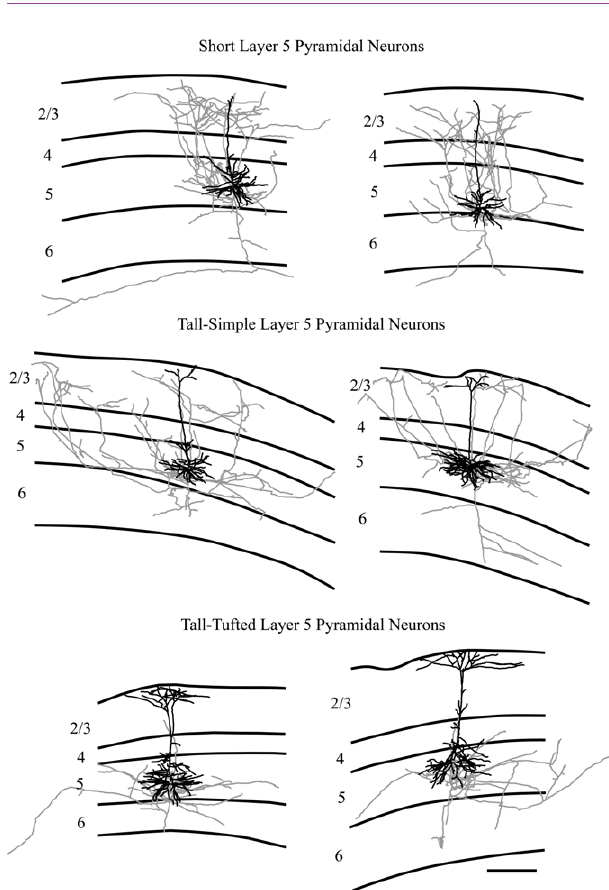
Figure 5. Representative examples of reconstructions of neurons from each injection site. Neurons are illustrated with axons depicted in gray and dendrites in black. Lines defi ne the laminar boundaries for each cortical layer. The upper line indicates the top of the section, with layer 1 included with layer 2/3. Neurons are grouped according to cell type. The two short layer 5 pyramidal neurons illustrated are also included in Figure 3 , without the axons included. The scale bar is 250 microns and applies to all